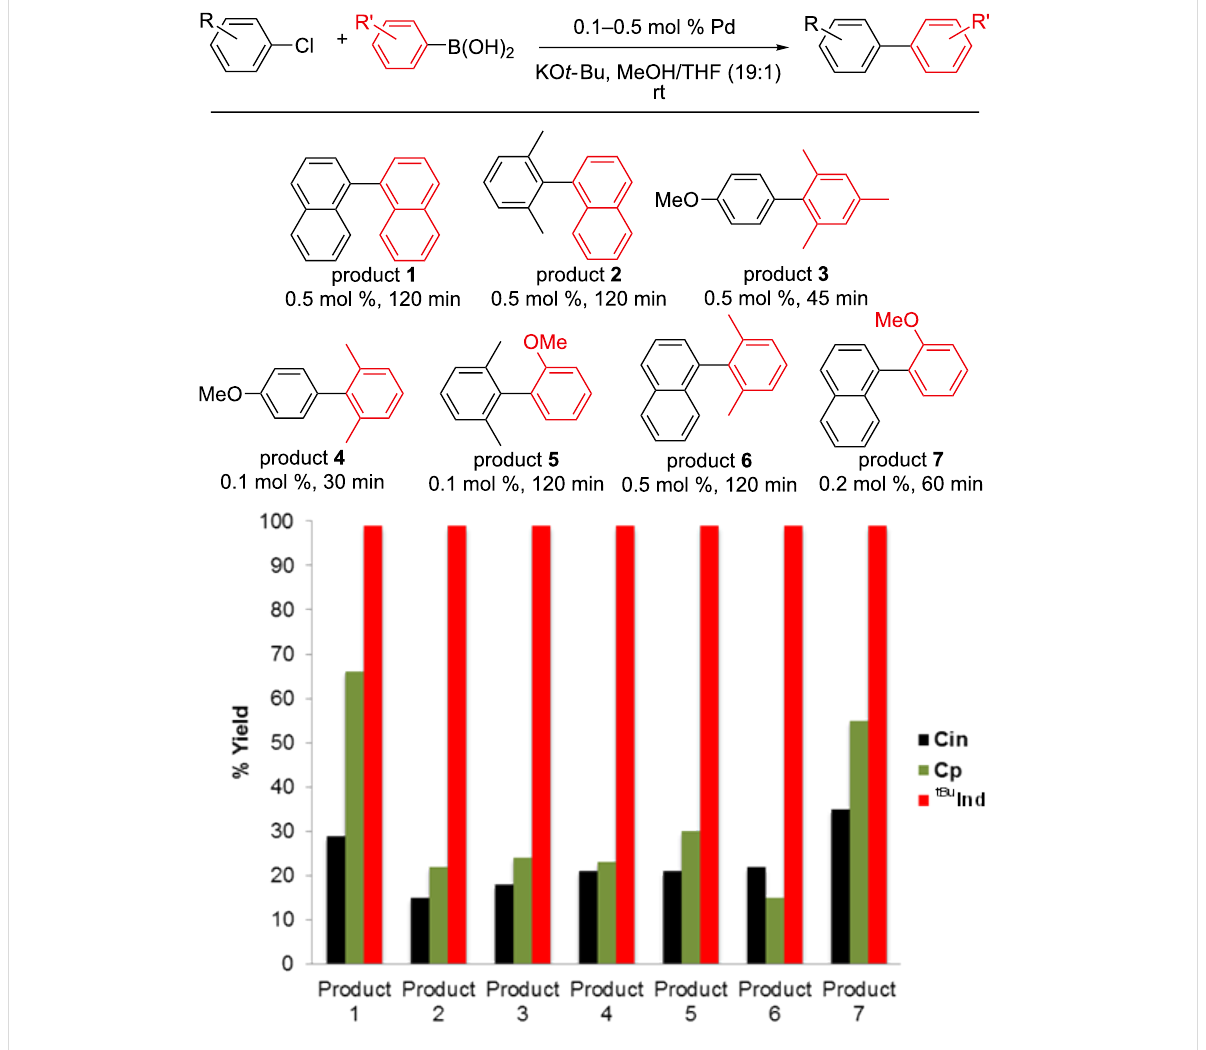
Figure 2: Comparison of catalytic performance of Cin , Cp and tBu Ind for a series of Suzuki–Miyaura reactions using KO t -Bu as the base. Yields for Cin and tBu Ind are from previous literature results [15]. All yields were determined using GC and are the average of two runs.